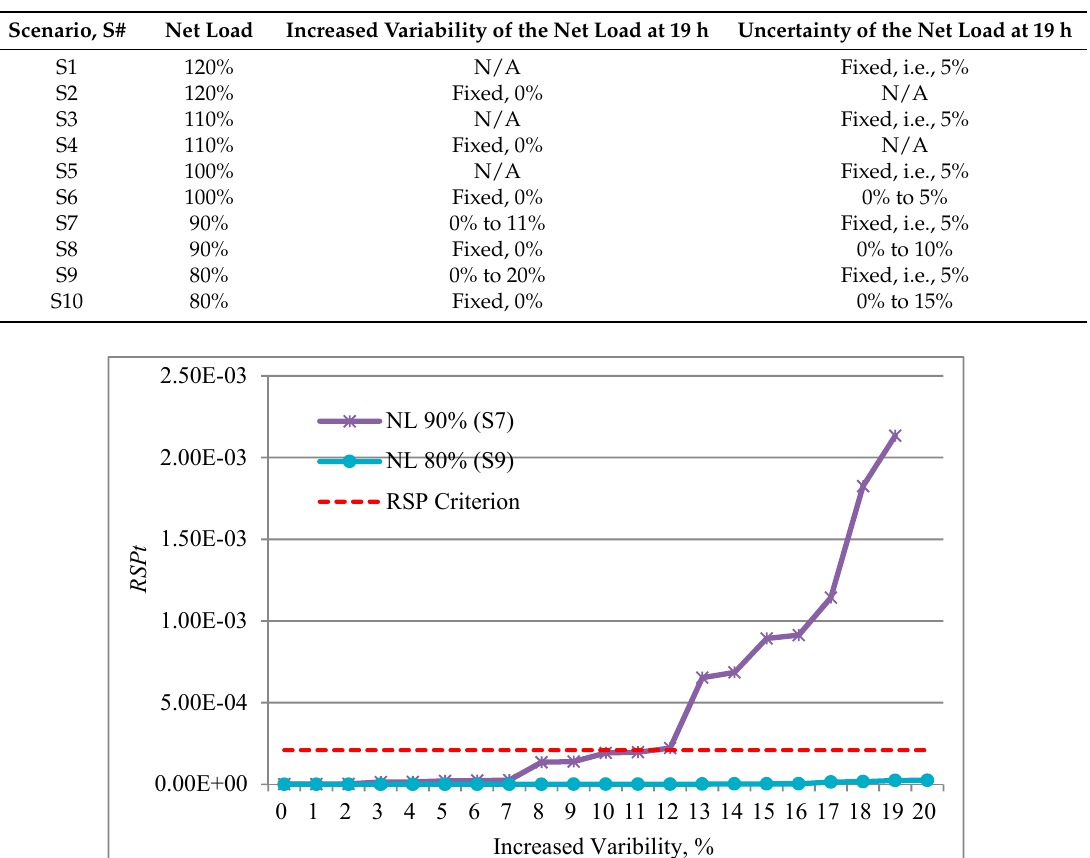
Figure 9. Results of sensitivity analysis for increased variability: enlarged graph for S7, S9, and RSP criterion.